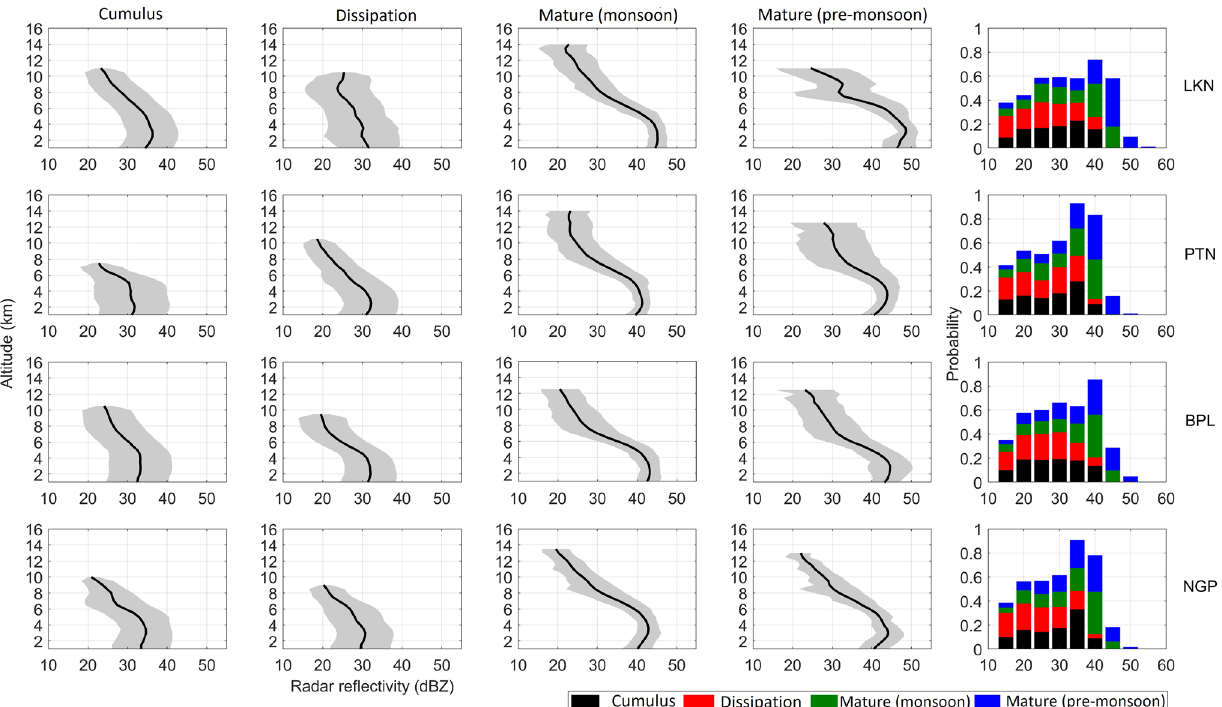
Figure 6. Statistics of VPRRs at cumulus, dissipation and mature phases of storm lifetime during the monsoon season. For comparison, VPRRs at mature phase are shown during the pre-monsoon season. The total numbers of VPRRs are 6948 (102), 4447 (29693), 260327 (21934) and 7392 (2083) at Lucknow, Patna, Bhopal, and Nagpur, respectively, during the monsoon (pre-monsoon) season. The thick line is the mean of all VPRRs, and the shaded region shows a 1 σ at each altitude level. The rightmost bar plots show the relative frequency of occurrence of Z e in different phases of storm